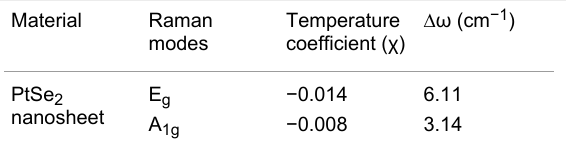
Table 1: Temperature coefficient values for the A 1g and E g modes in a PtSe 2 nanosheet sample.